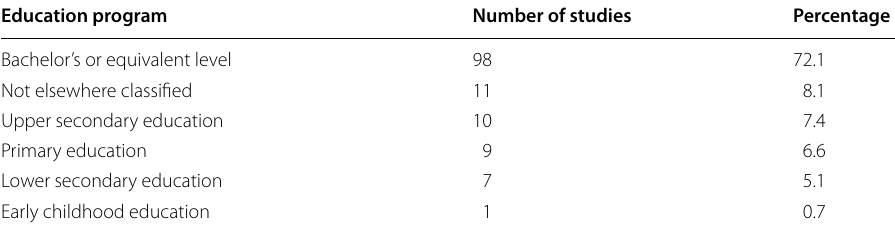
Table 5 Distribution of research